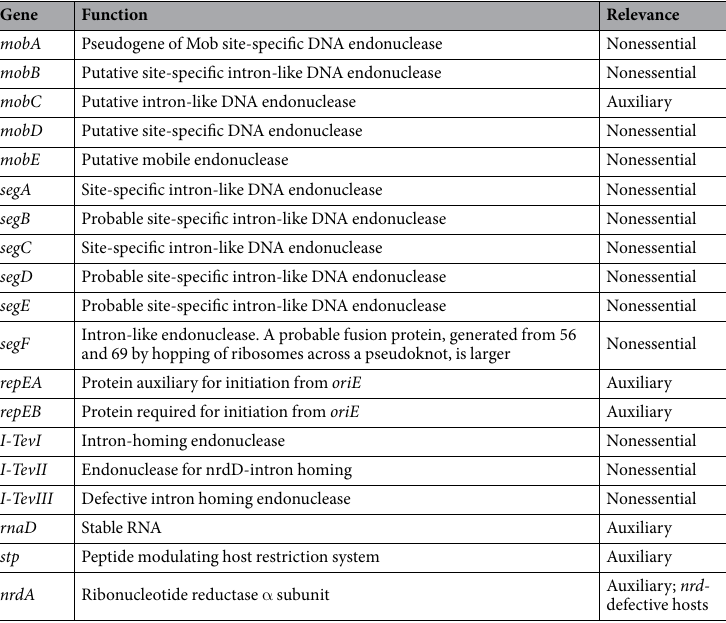
Table-1. Genes not predicted in vB_EcoM-UFV13 based on the reference genome Enterobacteria phage T4 (accession number NC_000866). Function and relevance were integrally withdrawn from Miller et al .